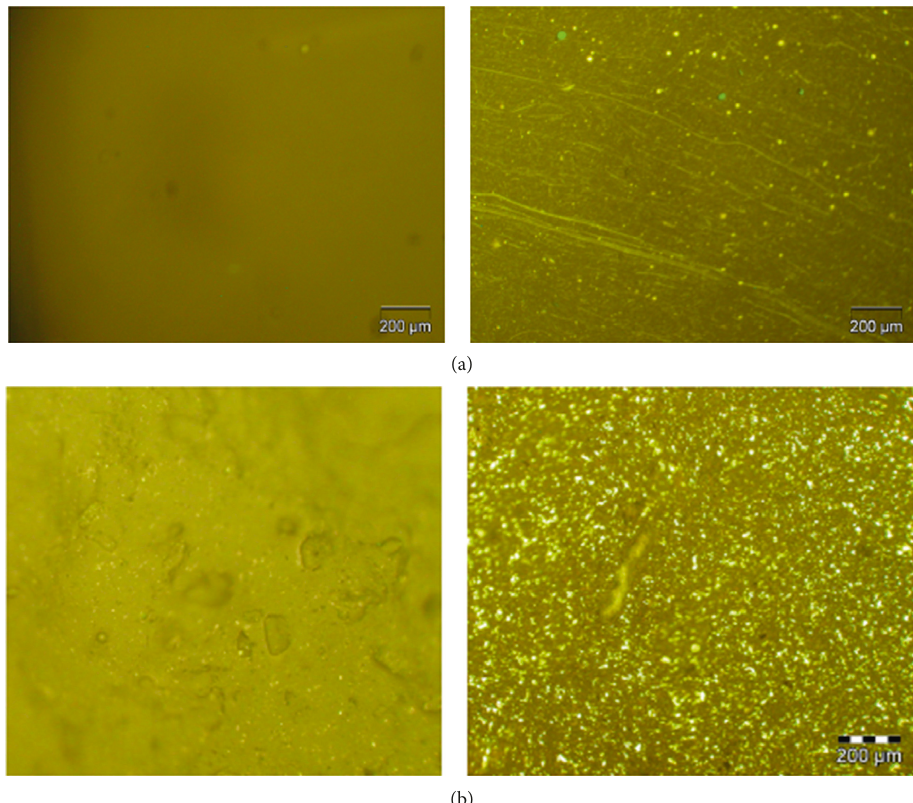
Figure 13: (a) Fluorescence microscopy of pure bitumen (left) and SBS modified bitumen (right). (b) Fluorescence microscopic pictures of the cross section of the PBmas (left) and the SBSmas (right) directly after being broken at 0 ° C. This figure is obtained from Qiu [40] (under the creative commons attribution license/public